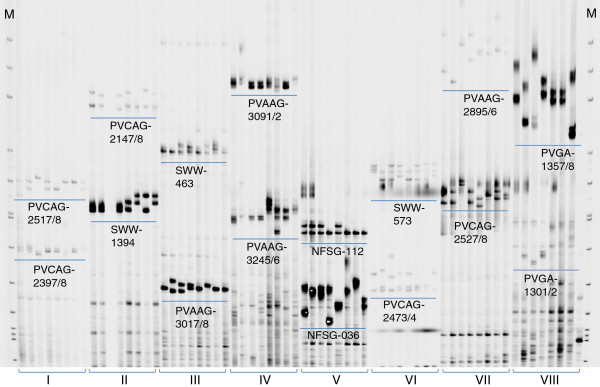
Primer pair (PP) combinations for the duplex PCR. The target bands for each PP (underline) and names of PPs are given. Here the duplex sets (I –VIII) were temporarily encoded and later they were integrated into the final list of duplex sets in Table 2. The DNA templates were the same as Figure 3.